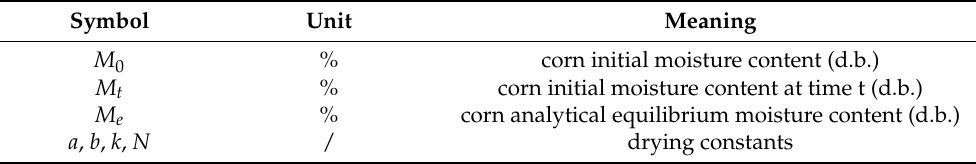
Table 5. Formula (5) and (6) symbols and meanings.